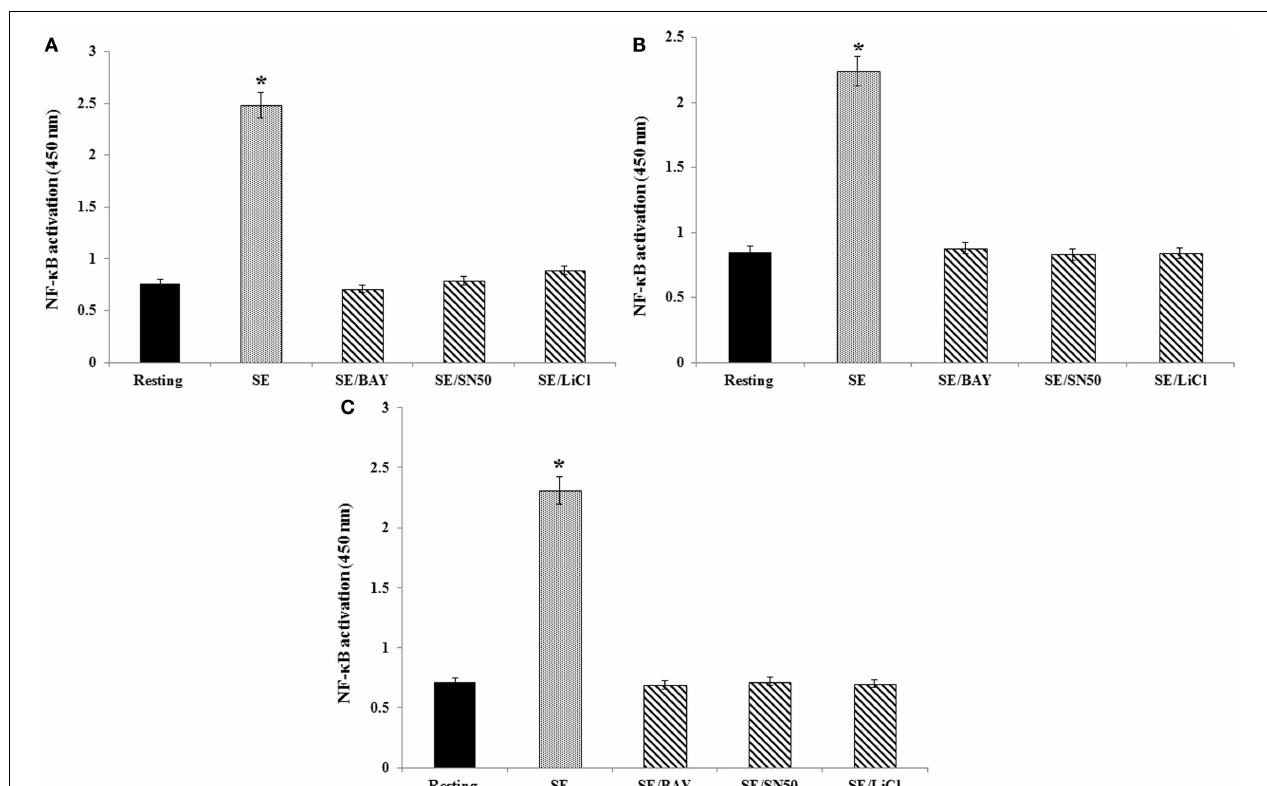
FIGURE 3 | Effect of NF- κ B or GSK-3 β inhibitors on binding of either c-Rel, RelB, or p50 subunits to a NF- κ B consensus sequence . Heterophils were aliquoted into sterile 2-ml Eppendorf tubes (1 × 10 7 cells/ml), where they were pre-incubated with the appropriate concentrations of the various inhibitors for 30min at room temperature. Following these pre-incubations, the heterophils were then stimulated with S . Enteritidis (10 9 cfu/ml) for 1h at